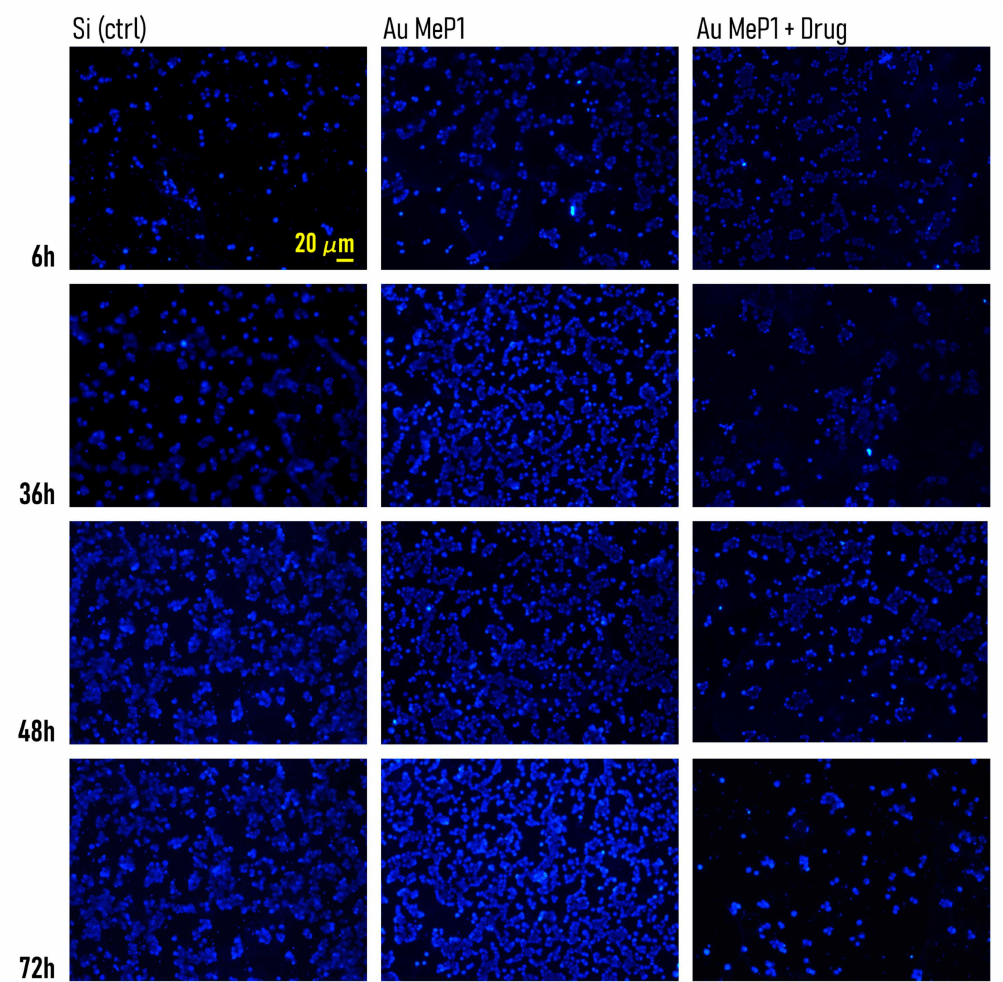
Figure 8. Fluorescence images of MCF-7 cancer cells growing on Au-MeP 1 substrates with and without the delivery of the antitumor agent PtCl(O,O (cid:48) -acac)(DMSO), at di ff erent time frames. In the experiments, unfunctionalized silicon was used as a